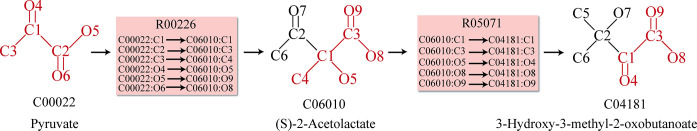
A linear atom group conserving pathway from pyruvate to 3-Hydroxy-3-methyl-2-oxobutanoate.This pathway is composed of reactions R00226 and R05071. The conserved atom group transferred from pyruvate to 3-Hydroxy-3-methyl-2-oxobutanoate is marked in red.